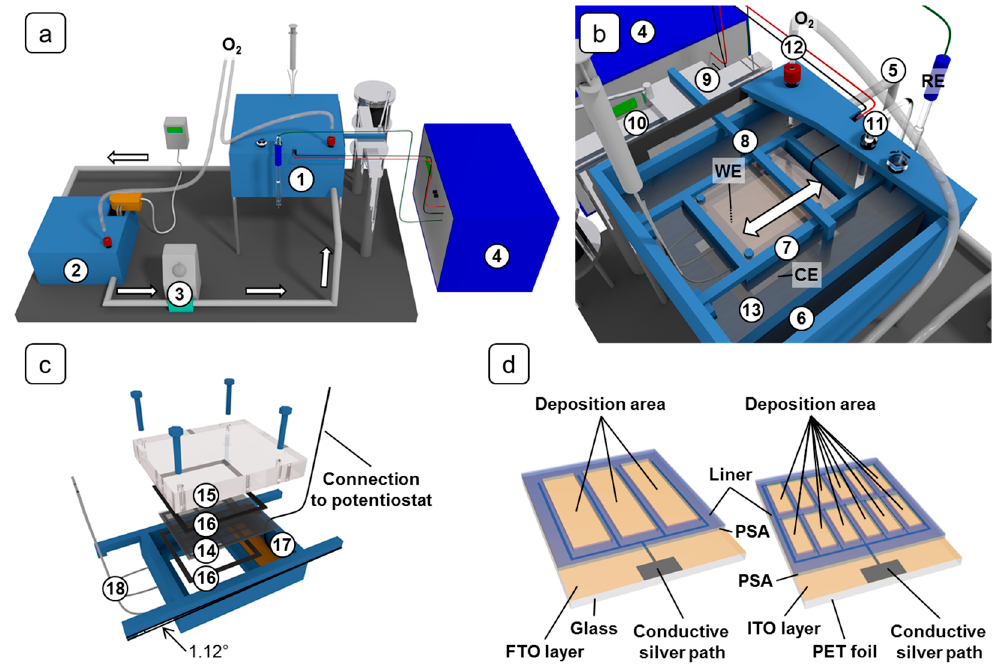
Figure 1. Schematic illustration of the miniplant setup. ( a ) Total view: (1) Deposition basin, (2) Tempering basin, (3) Diaphragm pump, (4) Potentiostat. ( b ) Deposition basin: (5) Inlet, (6) Overflow, (7) Substrate holder, (8) Paddle, (9) Slide, (10) Linear guide, (11) Salt bridge, (12) Glass frit, (13) Zinc foil. ( c ) Substrate holder: (14) Substrate, (15) pressure plate, (16) sealing mats, (17) connection area, (18) gas suction tubes. ( d ) Layout of the FTO-glass (left) and ITO-PET (right) substrates.